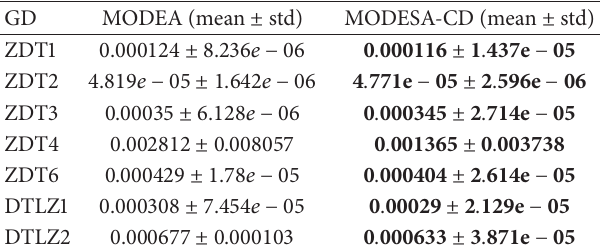
Table 6: The mean and standard deviation GD-metric values of nondominated solutions in 10 runs where 𝑁 = 100 and 𝑇 = 250 .